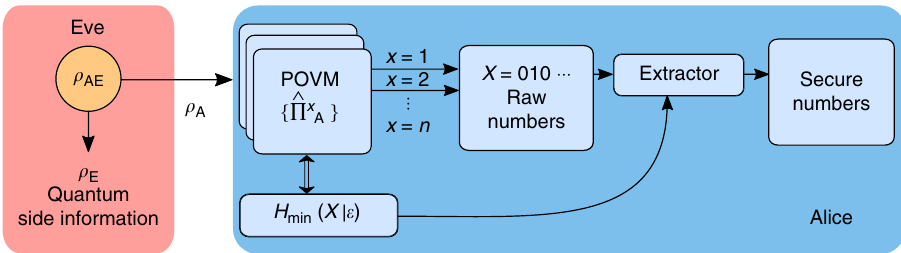
Fig. 1 Structure of the Source-DI protocol. In the general Source-DI scenario, Eve prepares the state ρ A that she sends to Alice such that her puri fi cation gives her the maximal guessing probability on Alice ’ s outcome. The structure of the POVM chosen by Alice to measure ρ A already impose a lower bound X jEÞ , independently from the input state or the output of her measurement (see Proposition 1). This bound is used to calibrate an extractor that on H min ð returns, at each round of the protocol, secure random bits when applied to Alice ’ s